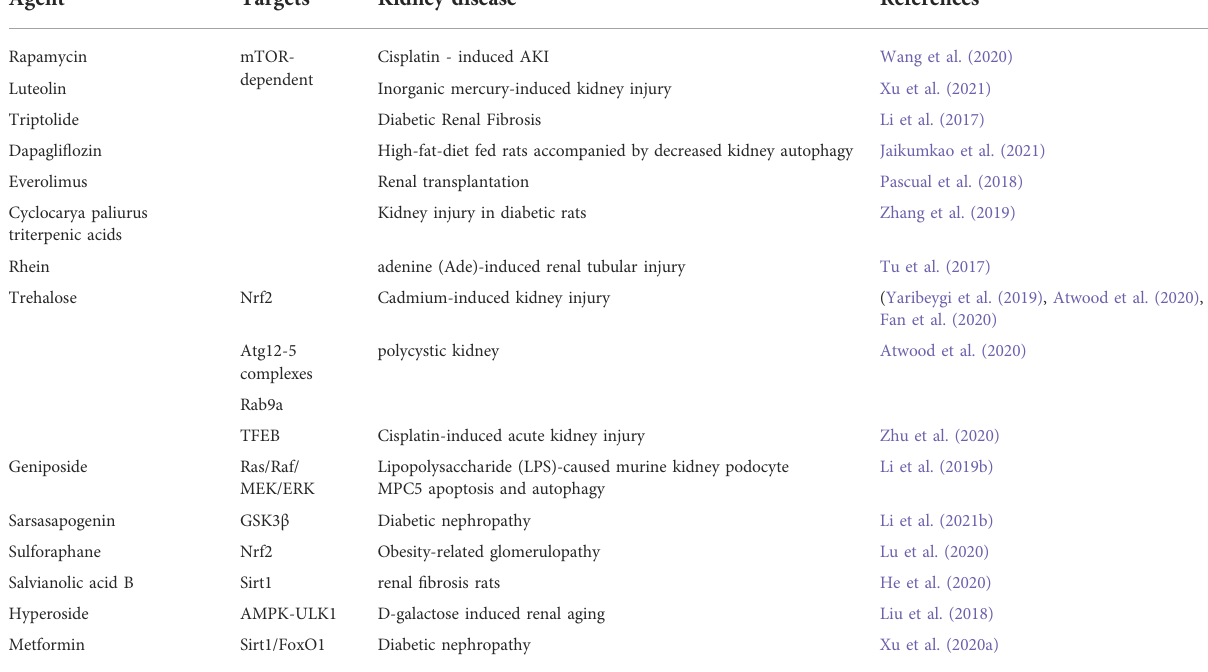
TABLE 2 Autophagy enhancer in kidney